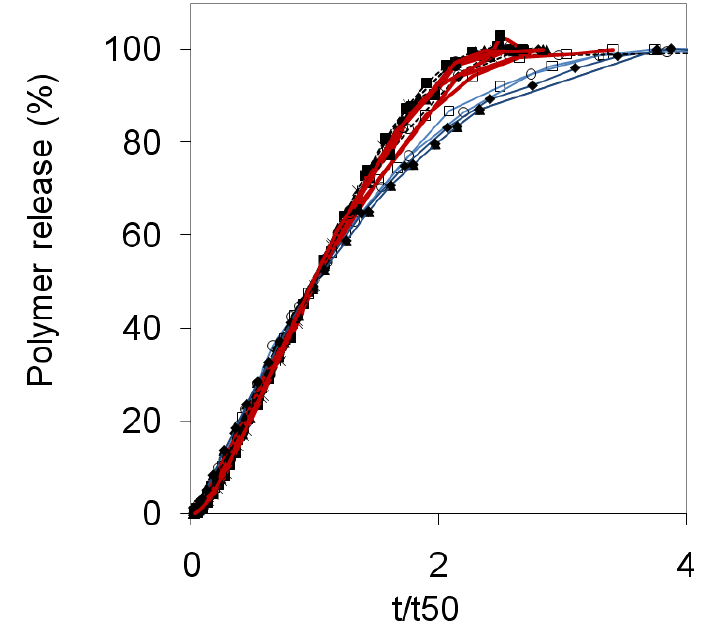
Figure 5. The polymer release is plotted against the reduced time (t/t line), HPMC 60SH (black line) and PEO (red line, adopted from reference [7]) as indicated in the figure legend. 100:0 samples are represented by open squares, 90:10 by filled diamonds, 50:50 by filled triangles, 30:70 by filled squares, 0:100 by asterisks and the nonmixed samples by